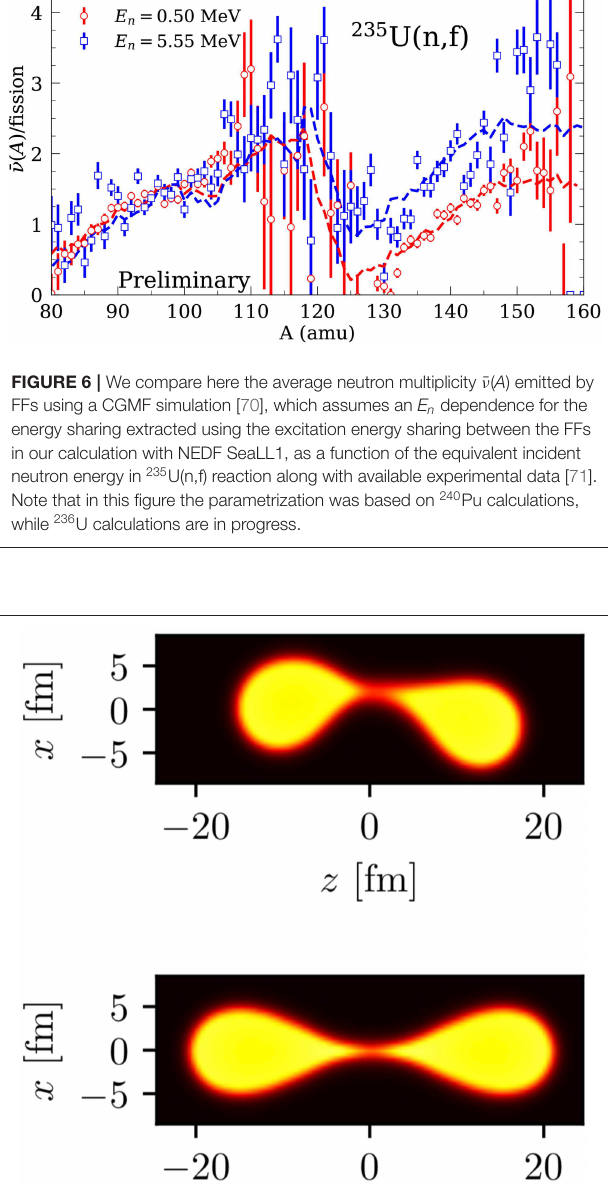
FIGURE 7 | In the upper panel we show a typical scission configuration when unlimited type of fluctuations are allowed as compared to a typical TDSLDA scission configuration, in which axial symmetry is assumed in this case for 258Fm. This figure is reproduced form Bulgac et al. [81] under the terms of the American Physical Society copyright